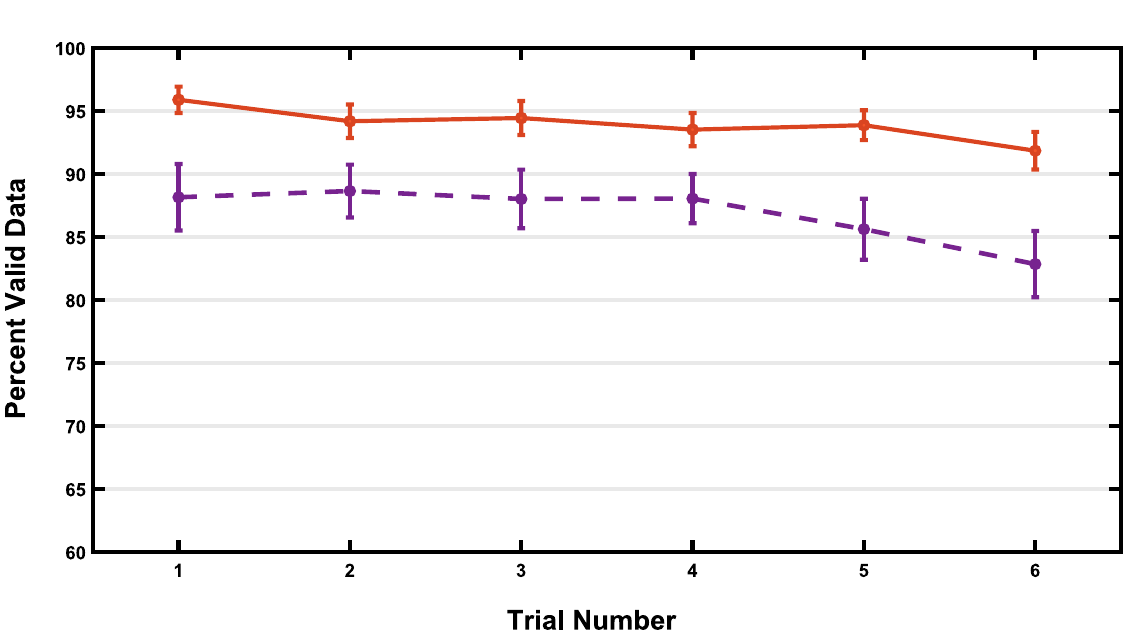
Fig 10. Percent of valid data in thresholded and unthresholded trials. The percentage of valid data across thresholded (orange) and unthresholded (purple) trials is shown. The unthresholded trials include data from all 50 participants who completed the eye-tracking task. Thresholded trials include the 32 participants whose data met or exceed 70% valid data across all 6 trials. In this population of young infants, there was no statistically significant loss of valid data across time in either the thresholded or unthresholded trials. Data presented as mean +/- 1 standard error of the mean